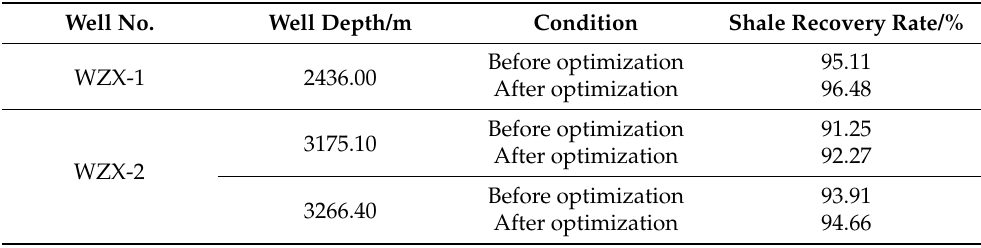
Table 4. Comparison of shale recovery rate between before/after optimization of solid-free organic salt drilling